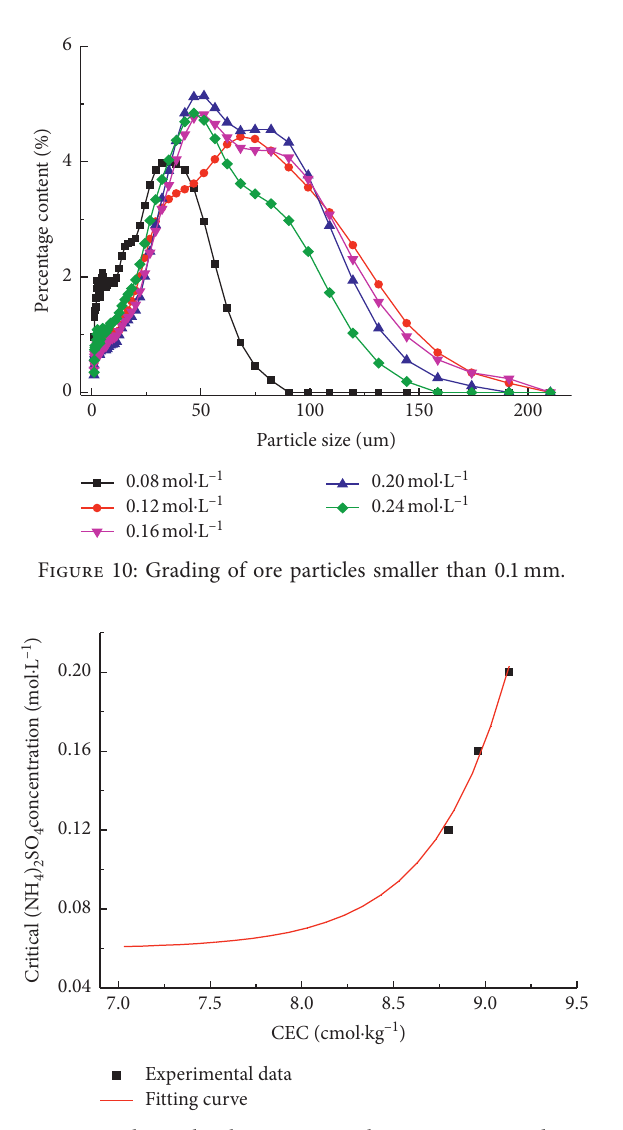
Figure 11: Relationship between critical concentration and